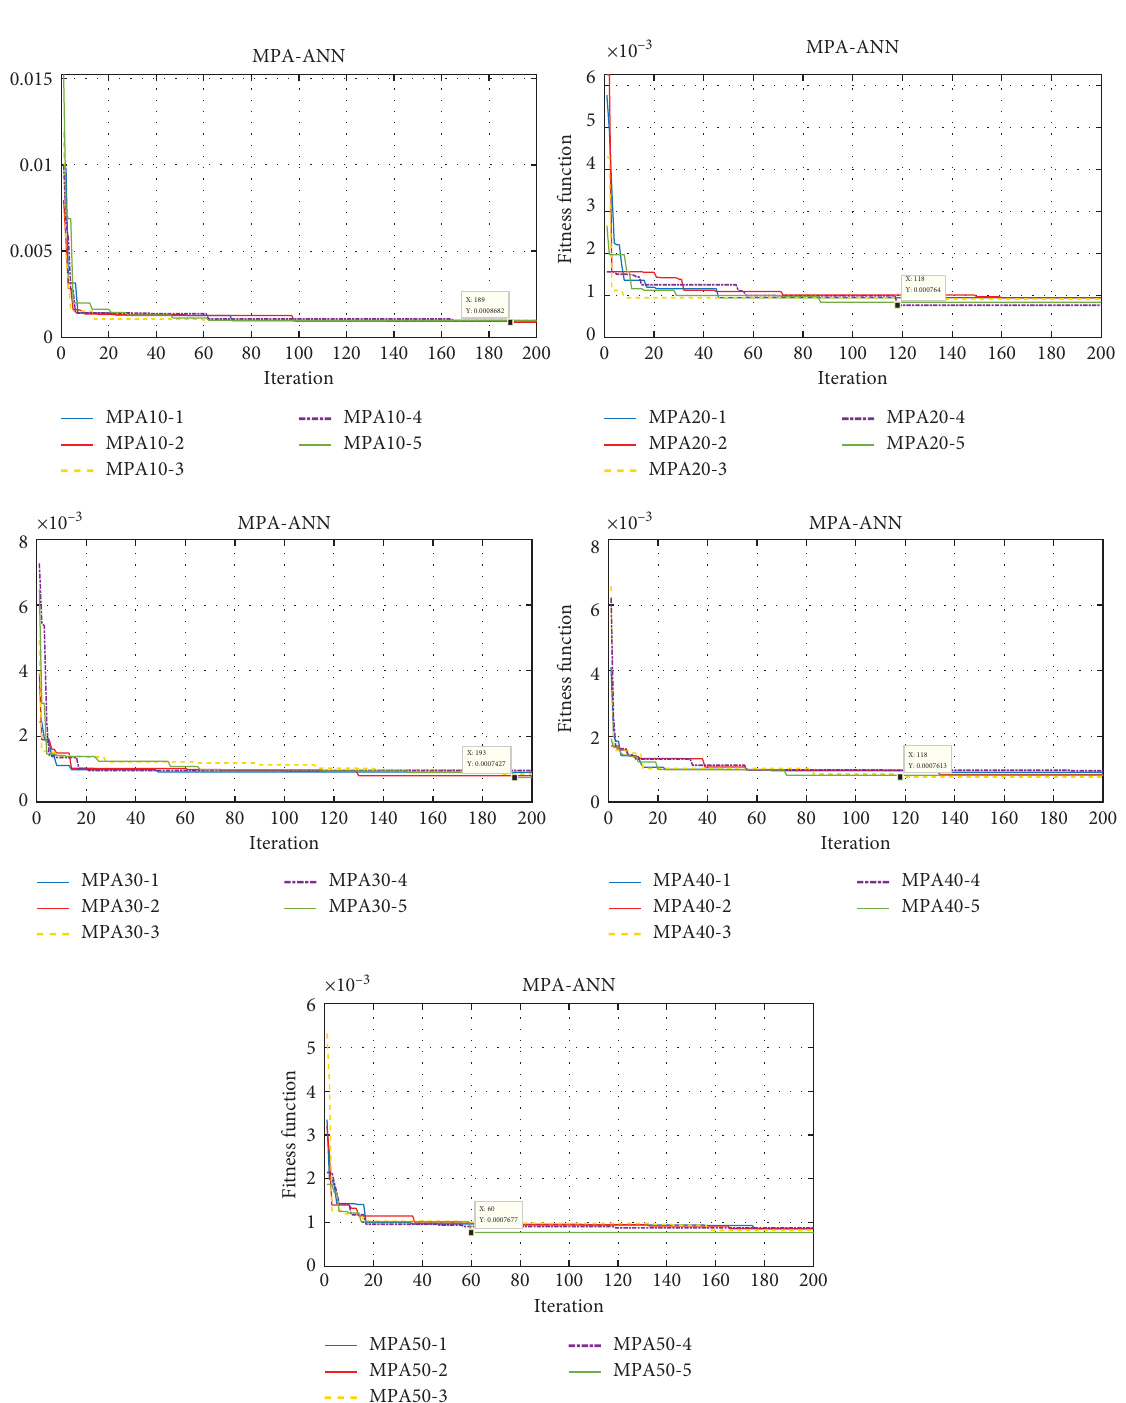
Figure 6: Performance of MPA-ANN algorithm with five trials for each swarm